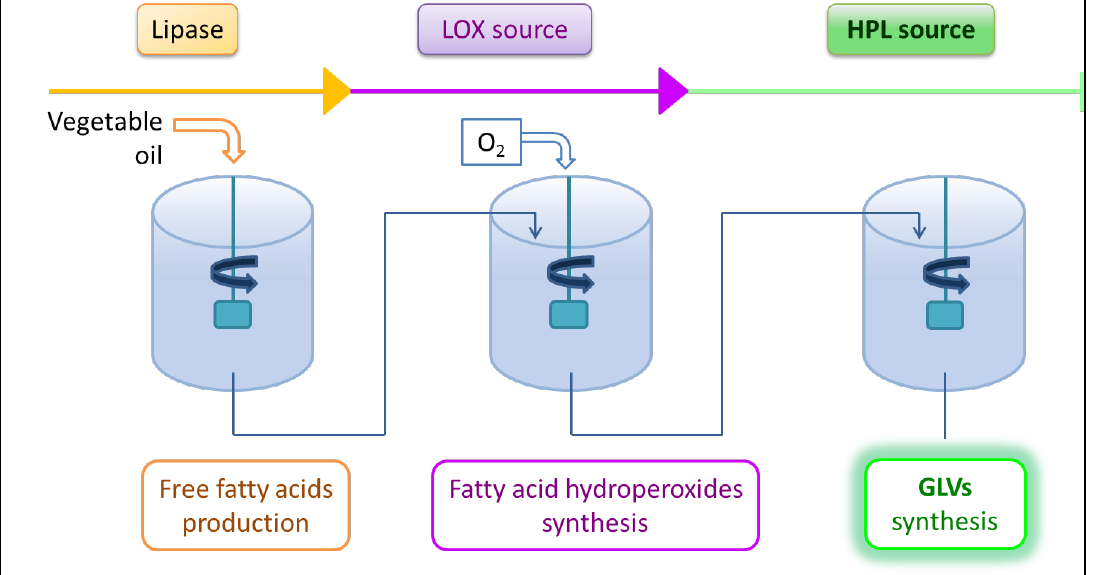
Figure 6. Biotechnological process of GLVs production in bioreactor. Biotechnological processes are based on the reactions of the LOX pathway. First, a vegetable oil in emulsion is hydrolyzed by the action of a lipase to release the fatty acids. Then, a lipoxygenase catalyzes the dioxygenation of the polyunsaturated fatty acids into hydroperoxides. HPL acts on these hydroperoxides to produce C6 or C9 aldehydes that are GLVs.